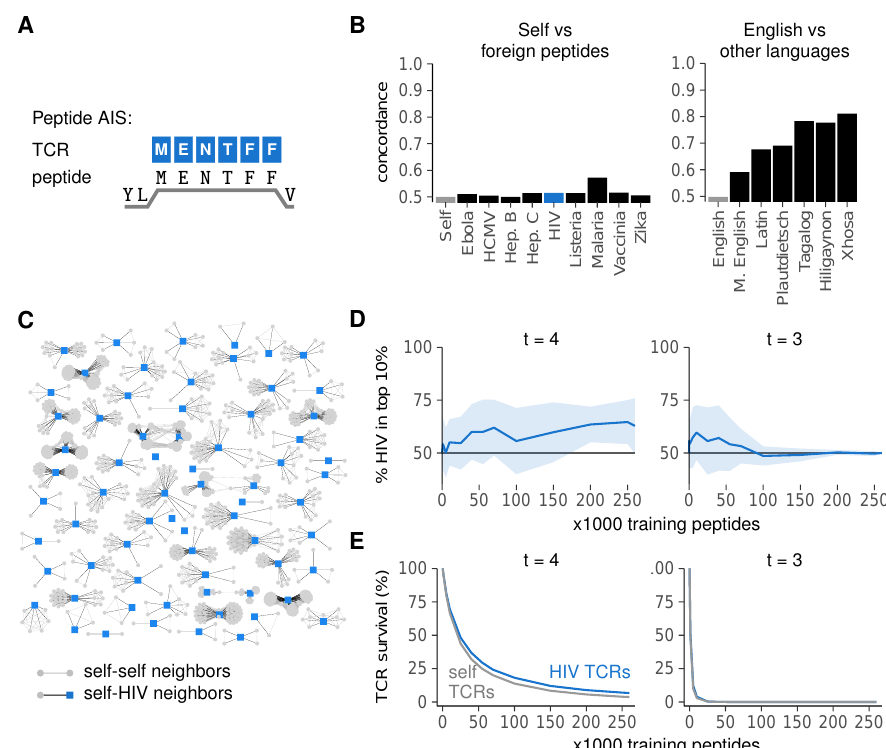
Figure 5. High similarity between self- and foreign peptides hampers their discrimination by the immune system. ( A ) the peptide AIS, in which TCRs bind to peptides on MHC-I (HLA-A2:01) focusing on the six residues at positions 3–8; ( B ) concordance for self versus foreign peptides (left) compared to that for English versus other languages (right). Language concordances from Figure 4F are included for comparison; ( C ) graph of HIV peptides and their neighbors. Edges connect peptides that have at least 5/million pre-selection TCRs in common; ( D ) percentage of HIV-peptides among the 10% most frequently recognized peptides after negative selection (mean ± SD of 30 simulations); ( E ) mean ± SEM percentage surviving TCRs for self and HIV peptides after negative